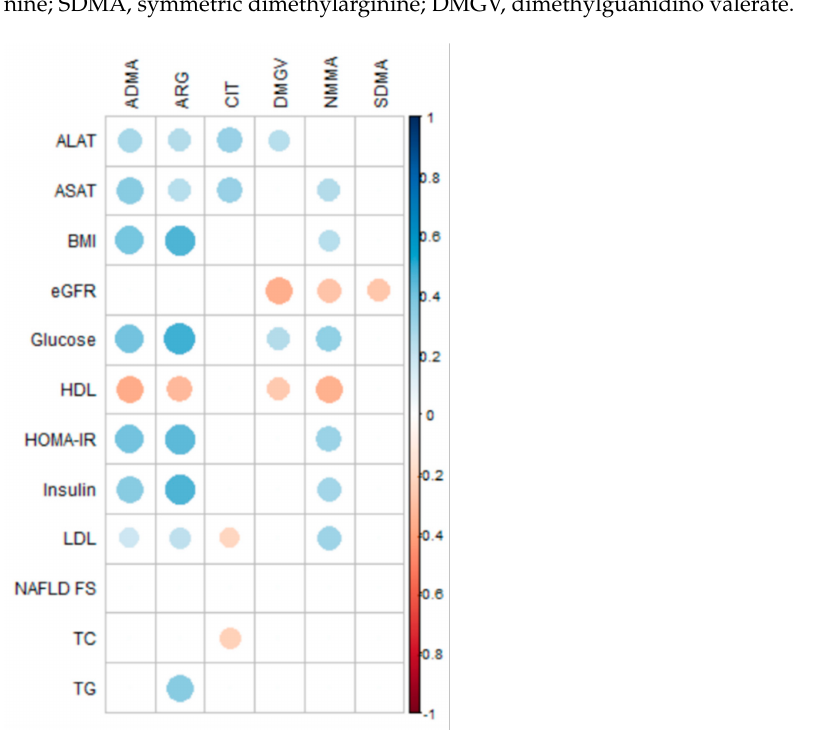
Figure 4. Spearman correlations obtained between the methylarginine metabolites and the main clinical parameters of the obese patients (all values, n = 122). Blue and red colors indicate positive and negative correlations, respectively. Only significant correlations are presented ( p < 0.05). The size of the circles indicates significance. NMMA, N-monomethylarginine; ADMA, asymmetric dimethy- larginine; SDMA, symmetric dimethylarginine; DMGV, dimethylguanidino valerate; BMI: body mass index; TC: total cholesterol; TG: triglycerides; HDL-C: high-density lipoprotein cholesterol; LDL-C: low-density lipoprotein cholesterol; ASAT: aspartate aminotransferase; ALAT: alanine aminotrans- ferase; HOMA-IR, homeostasis model assessment of insulin resistance, NAFLD FC, nonalcoholic fatty liver disease fibrosis